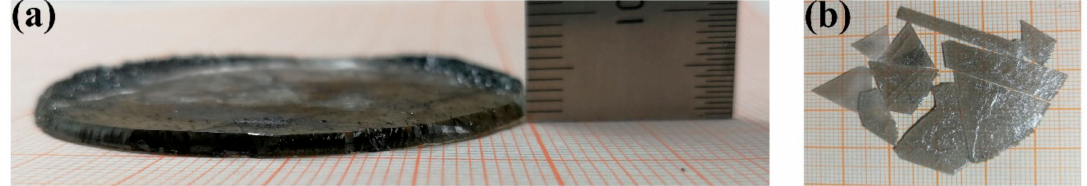
Figure 7. ( a ) Digital camera image of the freestanding GaN crystal produced using three-step process; ( b ) vestigial